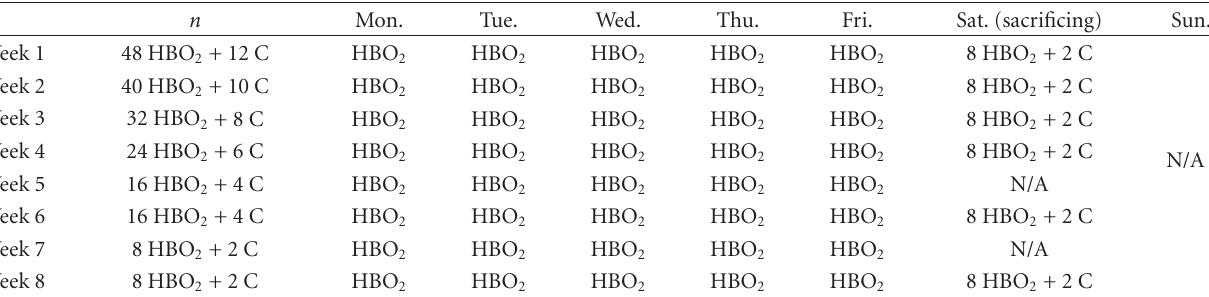
Table 1: Experimental schedule of the entire study. n